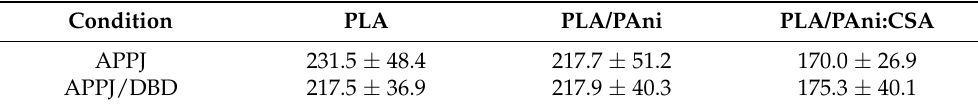
Table 1. Average diameters (nm) of PLA, PLA/PAni and PLA/PAni:CSA nanofibers.